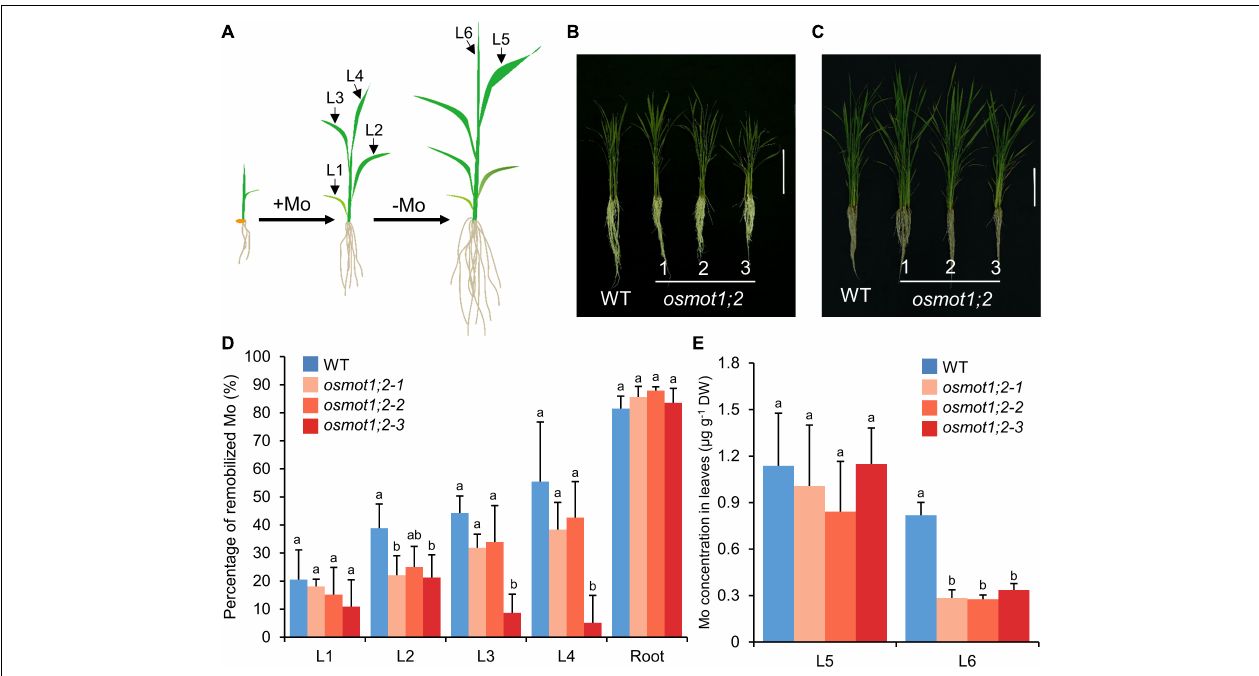
FIGURE 4 | Knockout of OsMOT1;2 decreases the remobilization of Mo from older leaves to young leaves under Mo-depleted condition. (A) Schematic diagram showing the experimental setup. WT and three knockout lines of osmot1;2 plants were grown in nutrient solution with 10 nM Mo until the fourth leaf was fully expanded. Plants were then transferred to the nutrient solution without adding Mo and were grown to six leaves stage. (B,C) Images of WT and three knockout lines of osmot1;2 at four leaves stage (B) and six leaves stage (C) . Vertical bar, 10 cm. (D) The percentage of Mo in roots and the first to fourth leaves (L1–L4) that were remobilized to new tissues. The percentage of remobilized Mo in roots or corresponding leaves was calculated by the difference of Mo concentrations between the four leaves stage and six leaves stage and divided by the concentrations at the four leaves stage. (E) The Mo concentrations in the fifth and sixth leaves (L5 and L6) at the six leaves stage were newly grown after Mo-depleted treatment. Data in (D,E) are presented as means ± SD with five or six biological replicates. Columns with different letters in (D,E) indicate significant differences at P < 0.05 (Tukey’s honestly significant difference